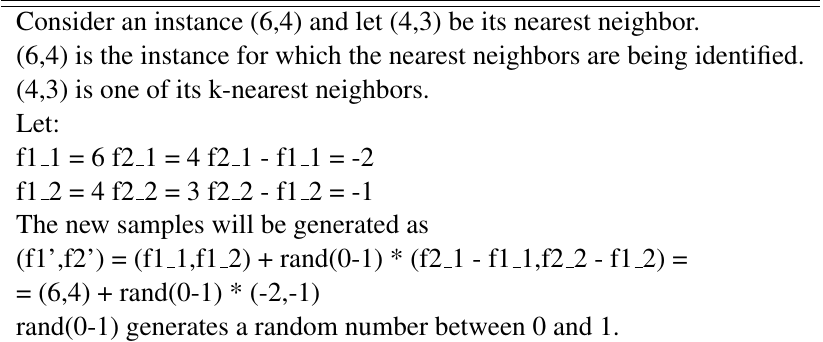
Table 2: Example of the SMOTE